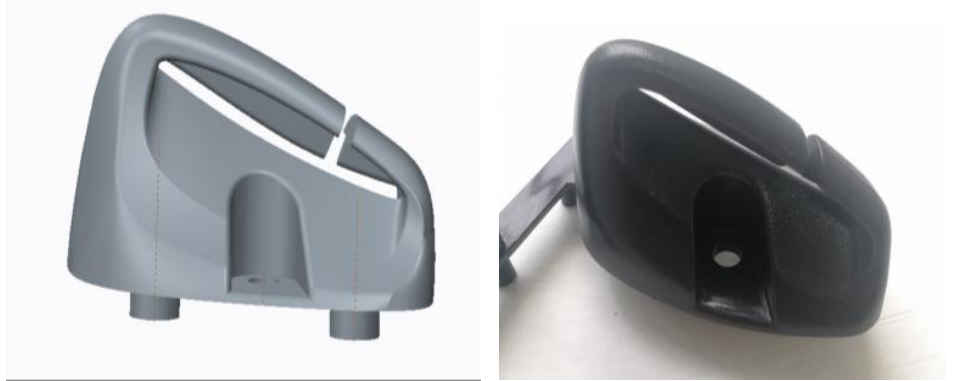
Figure 2. Auto interior part — seat belt guider sample images.